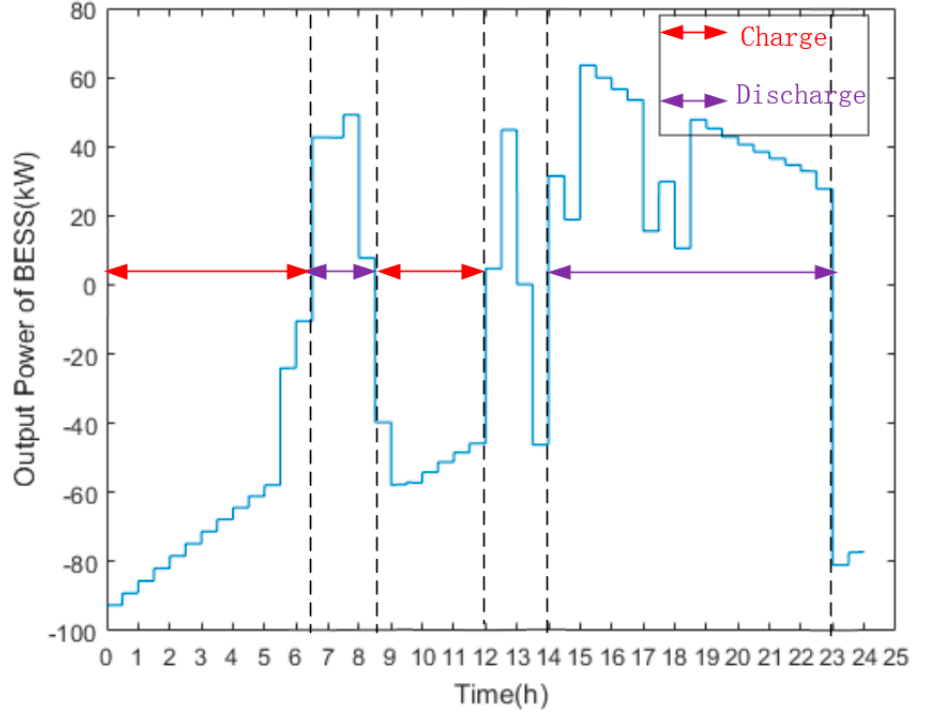
Figure 6. Output characteristic curve of VRB.